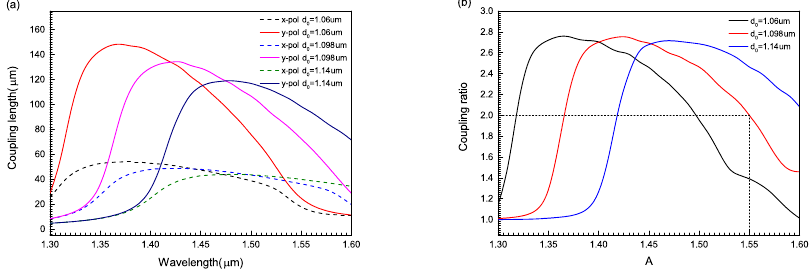
Figure 7. Influence of As 2 S 3 core diameter change on coupling length ( a ) and coupling ratio ( b ). Adjusting the distance between adjacent air holes can change the asymmetry degree of the double-core PCF, and then change the birefringence, which leads to the change of the coupling length in x- and y-polarized directions. When the As 2 S 3 core diameter is 1.098 µ m, as the adjacent pore spacing increases from 1.06 to 1.14 µ m, the evolution of the coupling length and coupling ratio of the circular double-core PCF with wavelength is shown in Figure 8. From Figure 8a, with the increase of wavelength from 1.35 to 1.60 µ m, the coupling lengths in x- and y-polarized directions first increase and then decrease. For the same wavelength, as the pore spacing decreases from 1.7 to 1.5 µ m, the PCF coupling length gradually decreases. This is mainly because the cladding pores around the core become tighter as the pore spacing decreases. The field energy is not easy to leak out, which makes it easier for the optical field energy to couple from one core to another, resulting in the decrease of coupling length. In addition, as the distance between adjacent pores decreases, the asymmetry of the structure around the core increases. This increases the birefringence, which in turn reduces the coupling length. From Figure 8b, with the increase of wavelength, the coupling ratio first increases and then decreases. When the pore spacing increases from 1.5 to 1.7 µ m, the coupling ratio increases at short wavelength and decreases at long wavelength. In addition, when the pore spacing is 1.5 µ m, the coupling ratio can reach the ideal value of 2 at the wavelength of 1.55 µ m. Hence, the desired beam splitting performance can be obtained by adjusting the pore